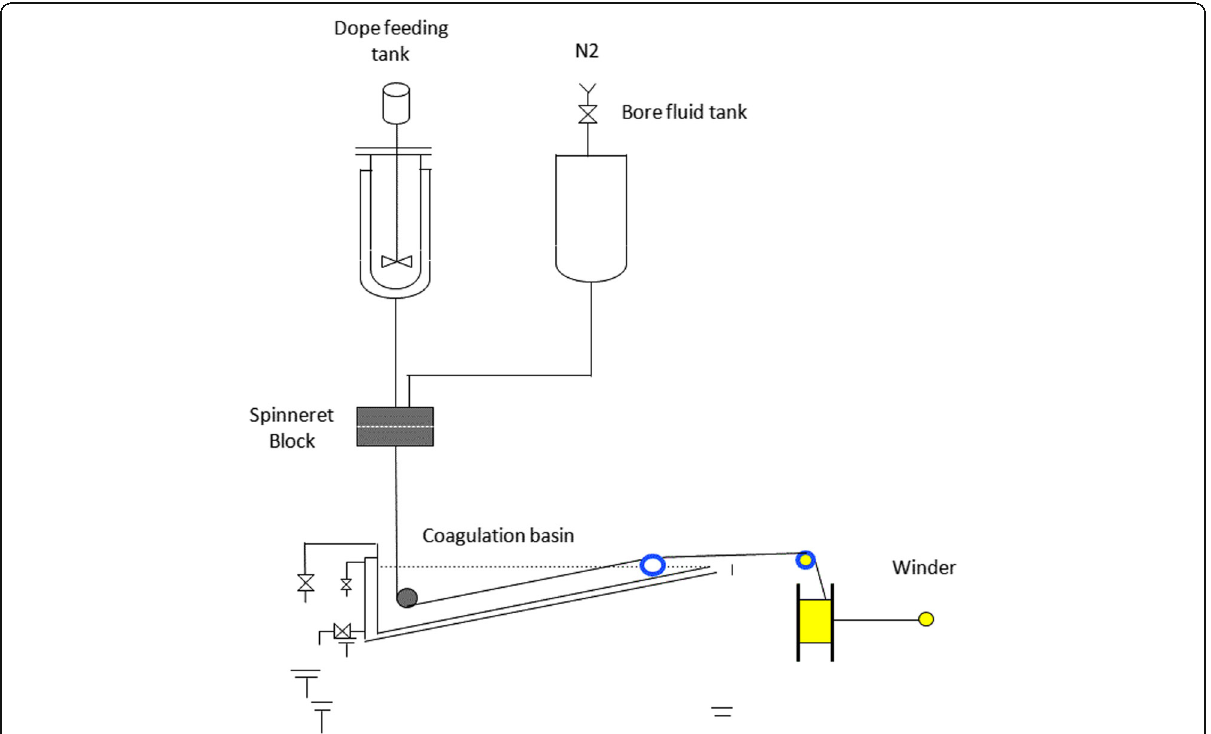
Fig. 1 Process design of MBHF membrane